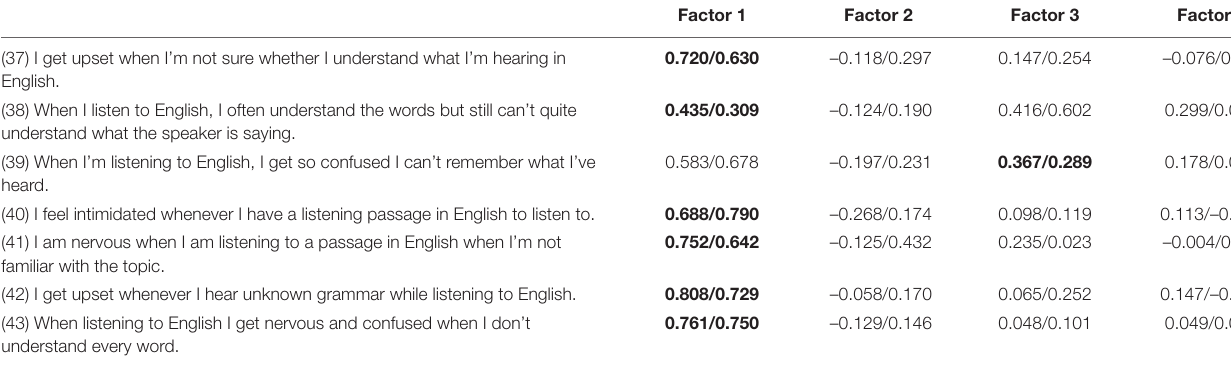
TABLE A3 | Loadings of principal components of FLLAS (phases 1/2) [KMO = 0.915 in phase 1 and 0.895 in phase 2 ( p ≤